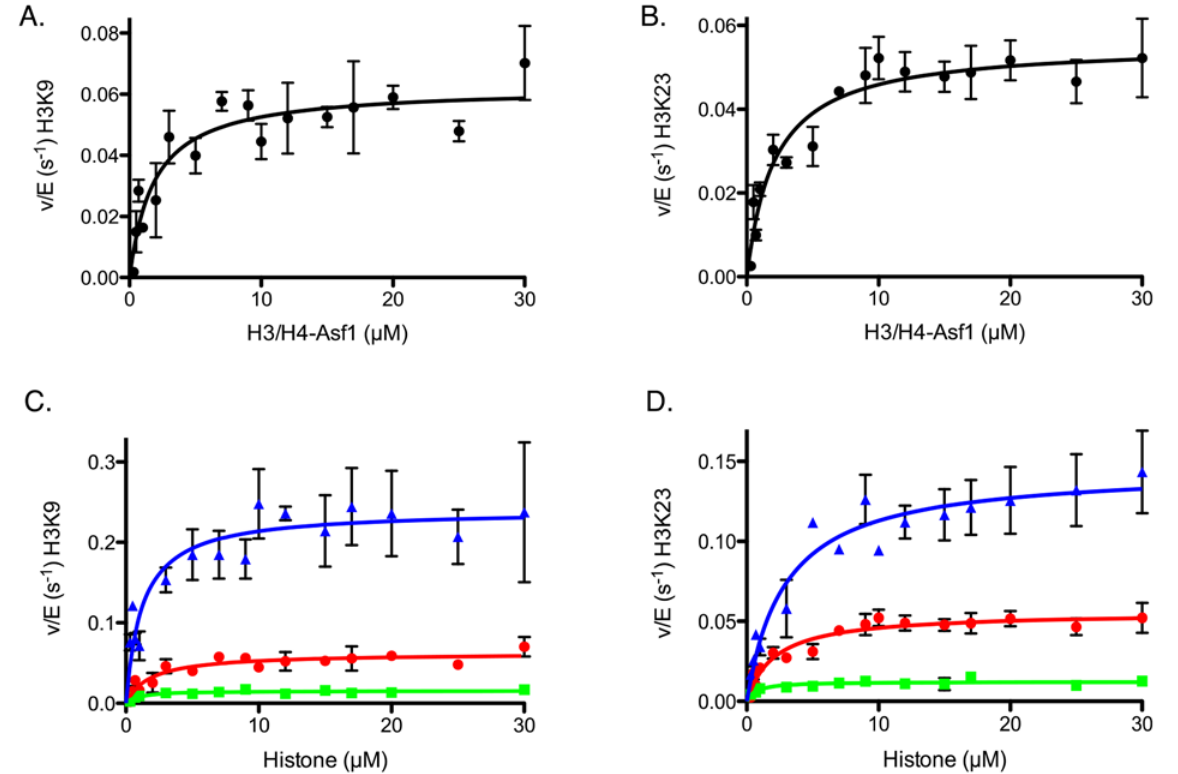
Fig 4. Determination of steady-state parameters of H3/H4-Asf1 acetylation catalyzed by Rtt109-Vps75 for individual lysines. The detailed experimental conditions are described in the section “ Steady-state kinetic assays for Rtt109-Vps75 ” . The error bar represents the standard error in v/E. Panels (A) and (B) show the Michaelis-Menten behaviors for H3K9 and H3K23, respectively, when titrating H3/H4-Asf1 in the presence of saturating acetyl- CoA. Panels (C) and (D) show the superposition of steady-state kinetics for H3K9 and H3K23, respectively, on different histone conformations (H3: blue triangle, H3/H4-Asf1: red circle, and H3/H4: green square). The apparent kinetic parameters are summarized in Table 1. When H3/H4 is complexed with Asf1, no cooperativity is detected, and the specificity and selectivity of K9 and K23 acetylation increases.